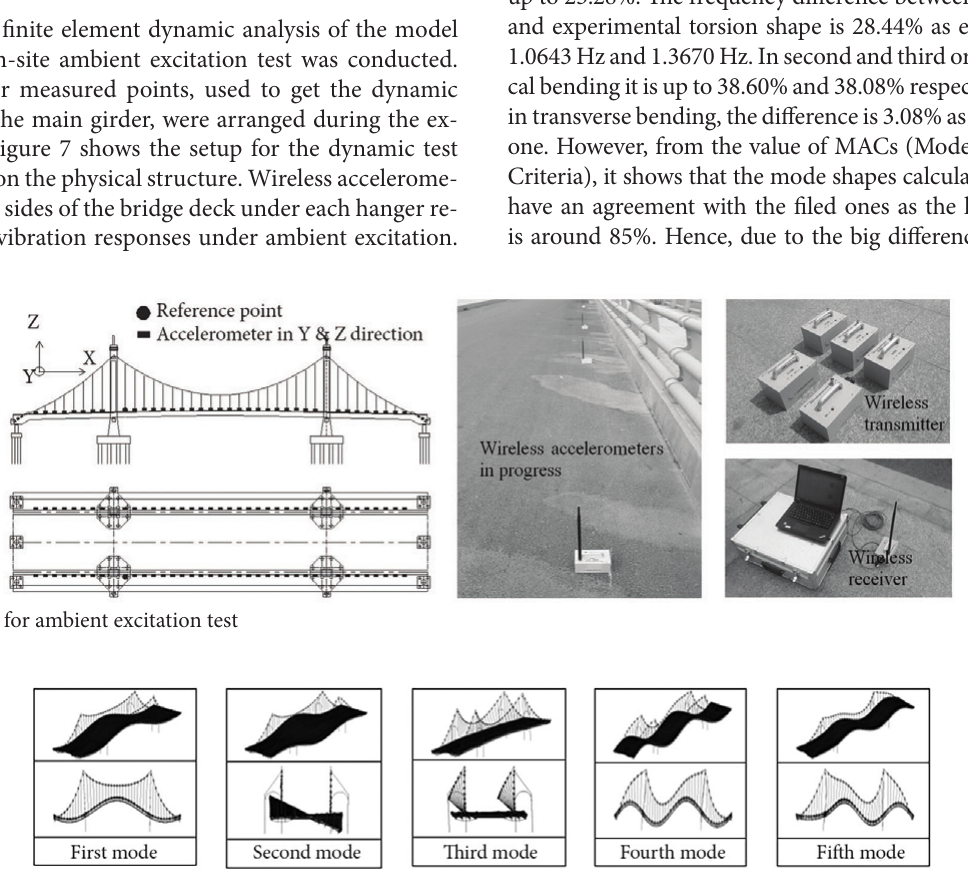
Fig. 8. The first five mode shapes of the main girder of Hunan Road Bridge from Finite Element Model Table 1. Detail dynamic characteristics of the main girder from theoretical and experimental analysis